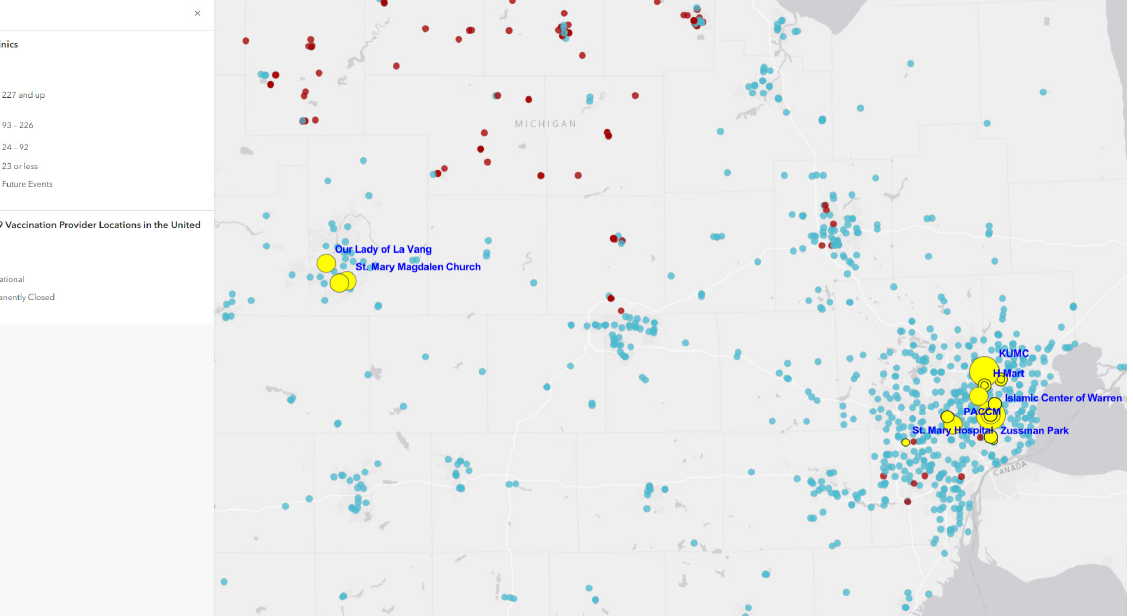
Figure 2. EMU CHDIS mobile clinics vs. Asian American populations.